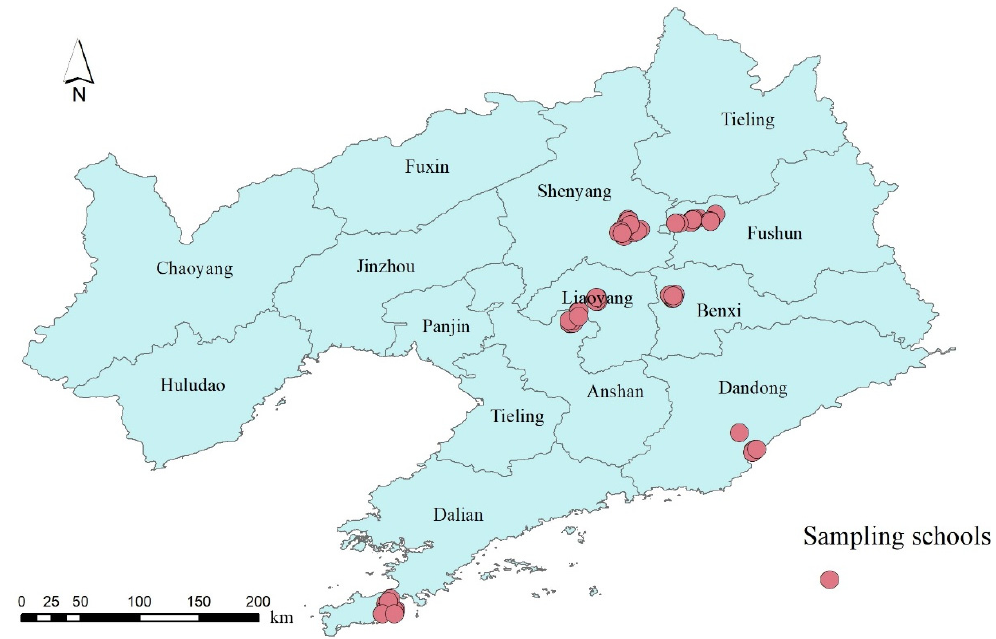
Figure 1. The map of Liaoning Province that shows the distribution of sampled schools in seven